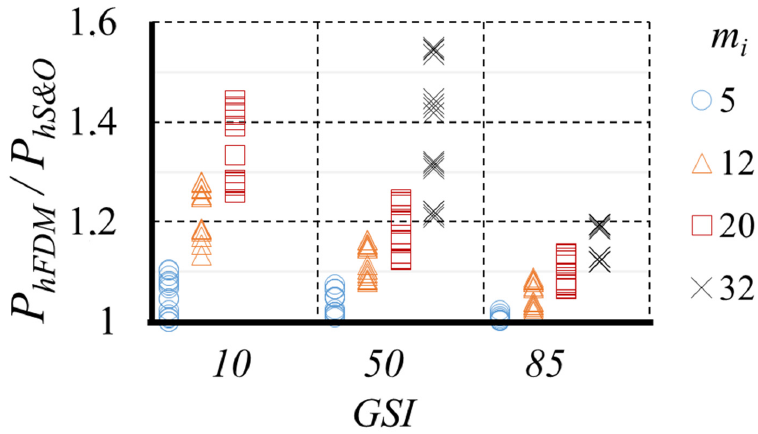
Figure 7. Relation between P hFDM and P hS&O depending on GSI and m i .